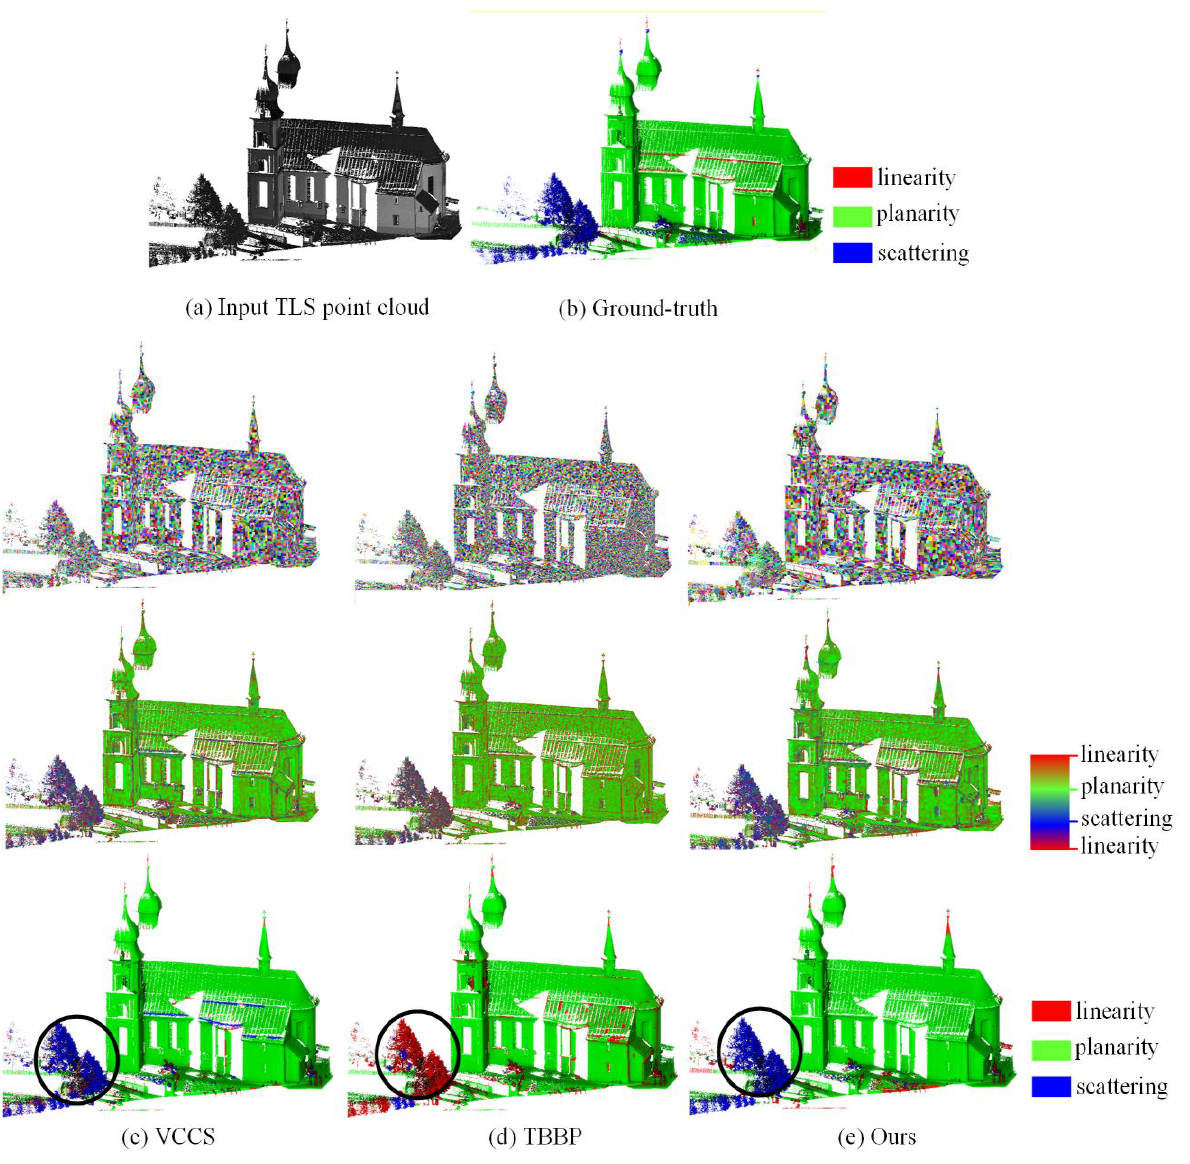
Figure 4. Comparison of structural segmentation results of the TLS dataset. (a) is the input TLS point cloud, (b) is the manually labeled ground-truth with red, green and blue referring to linearity, planarity and scattering, respectively. (c) – (e) show the segmentation results derived supervoxels generated by VCCS, TBBP and our method. In (c) – (e), from top to bottom are the random colour-coded supervoxels, visualized shape descriptors derived from supervoxels and the structural components colour-coded based on their